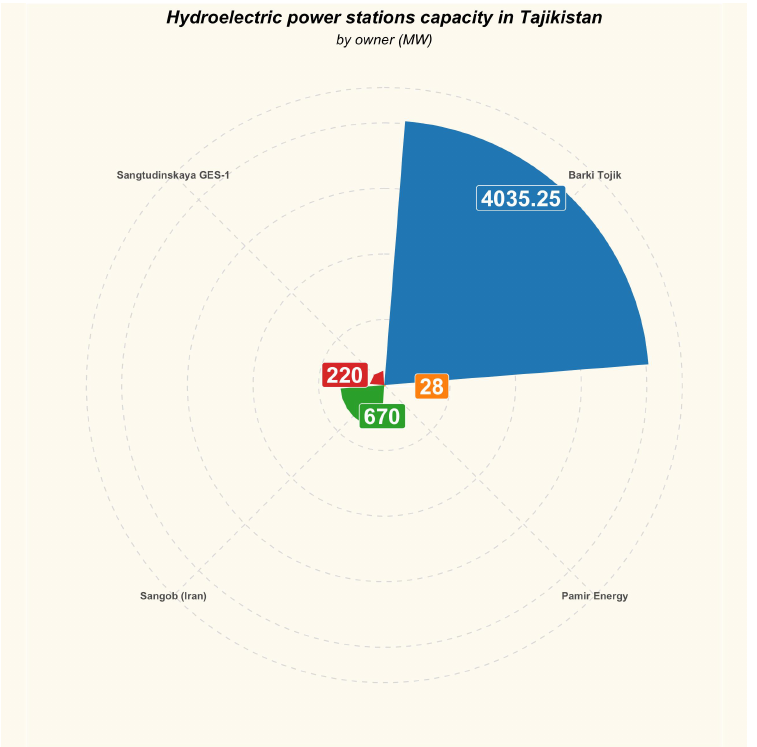
Figure 8. Hydroelectric power station capacities in Tajikistan by owner. Data source: Tajikistan Energy Ministry: Jelektrojenergeticheskaja